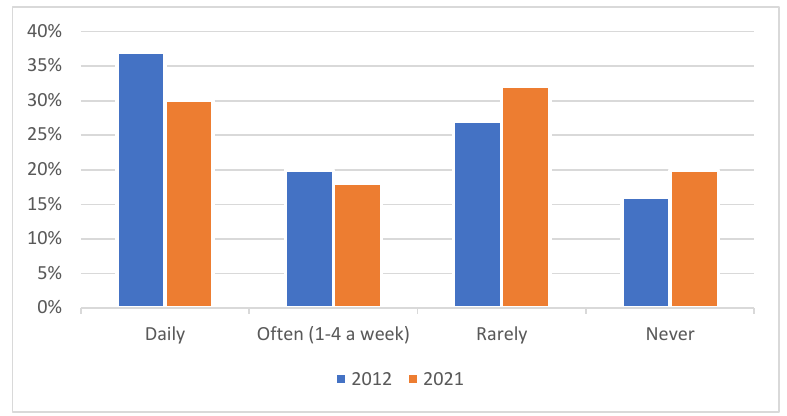
Figure 7. Public transport usage Oradea, provided by O.T.L.